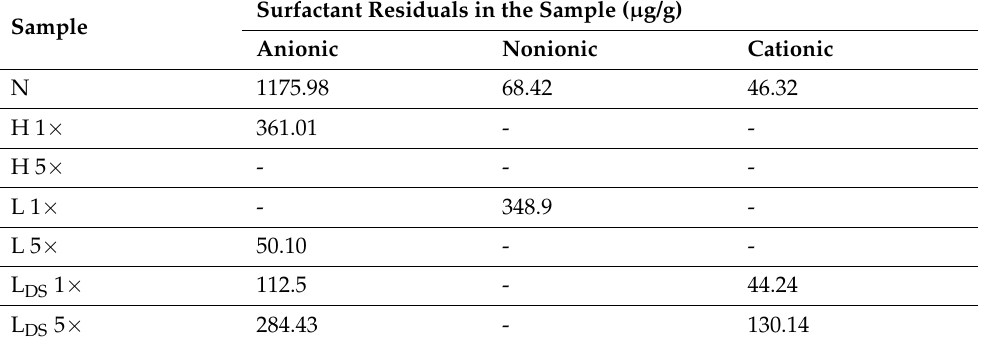
Table 10. Amounts of anionic, nonionic, and cationic surfactants in the aqueous extract of medical masks before and after washing—whole